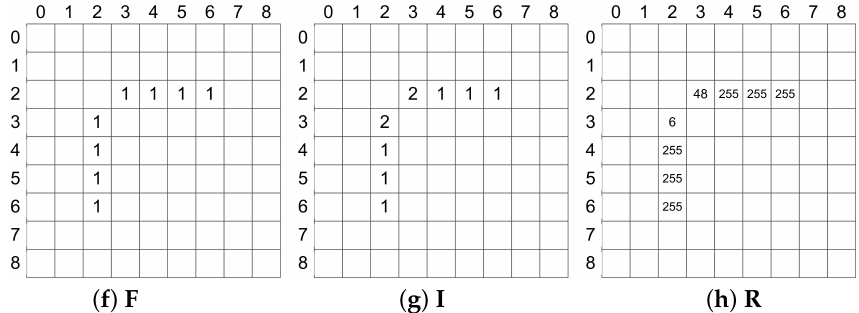
Figure 8. Illustrations of RSP updating from T 2 to T 3 . ( a ) The RSP matrix at j = 2, where six skeletal pixels have been identified. ( b ) Thinning result T 2 . ( c , d ) show respectively the updated RSP information for the 1-pixel (2, 3) and (3, 2) having zero C value in T 3 . ( e ) The updated RSP pixel is denoted with a gray square. The RSP matrix can be decomposed into F , I and R matrices, as shown in ( f , g , h ), respectively.